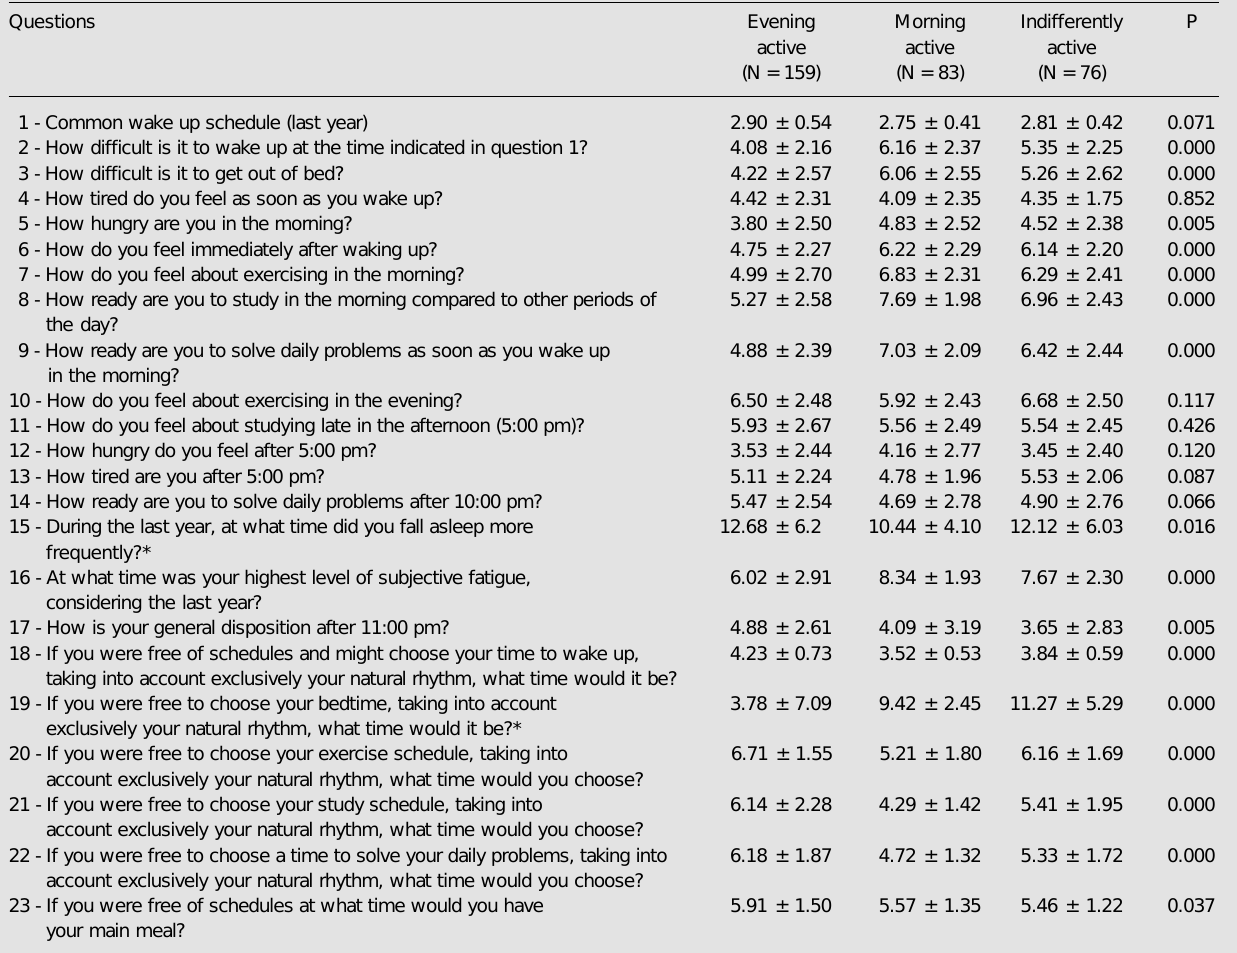
Table 1. Responses to the questionnaire composed of 23 self-report visual analog questions.